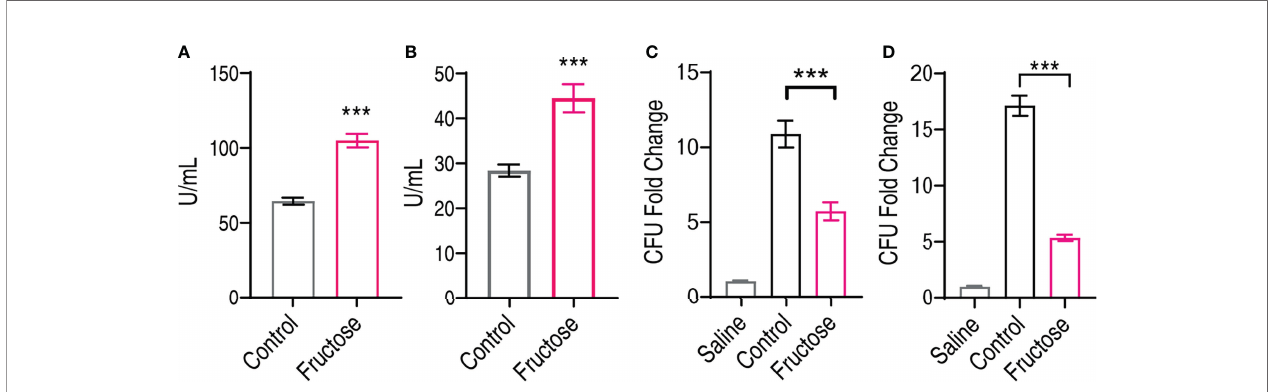
FIGURE 5 | Elevated lysozyme and complement activity in serum and liver can inhibit infected Aeromonas hydrophila . (A) Lysozyme activity of crucian carp serum being treated with saline or fructose (100 m g). (B) Complement activity of crucian carp serum being treated with saline or fructose (100 m g). (C) Bactericidal effect of serum treated with saline or fructose (100 m g). (D) Bactericidal effect of liver homogenates treated with saline or fructose (100 m g). All the data were plotted as histogram, and each dot represents one biological replicate. Scatter plot represents mean ± SEM of 10 biological replicates, signi fi cance was analyzed by the non- parametric Mann – Whitney U-test, ***p <